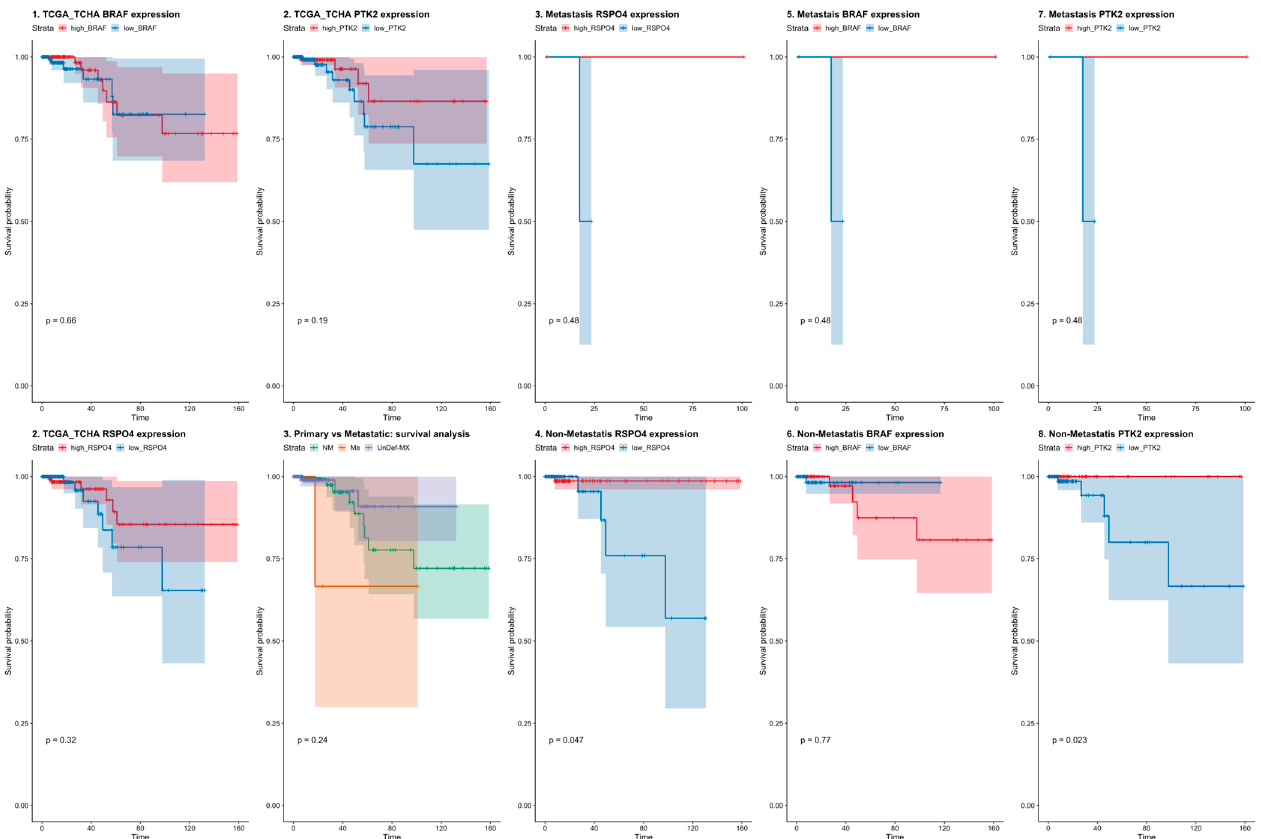
Figure 4. Survival rates in PTC patients from The Cancer Genome Atlas (TCGA) dataset considering BRAF, PTK2 (FAK), and RSPO4 gene expression. BRAF, PTK2 and RSPO4 expression levels discriminate between non-metastatic and metastatic PTC tumors with survival rates lower in PTC where these genes are overexpressed.